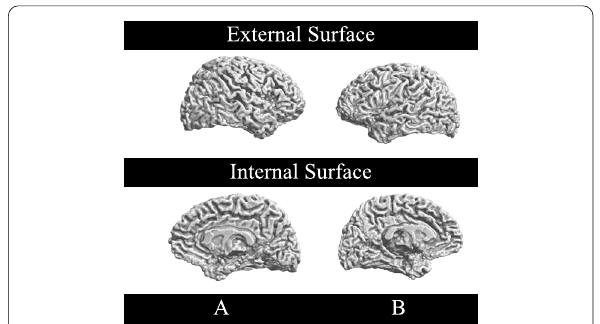
Fig. 3 Reconstructed surface by CAT12 toolbox. A Reconstruction of right hemisphere surface of the brain. B Reconstruction of left hemisphere surface of the